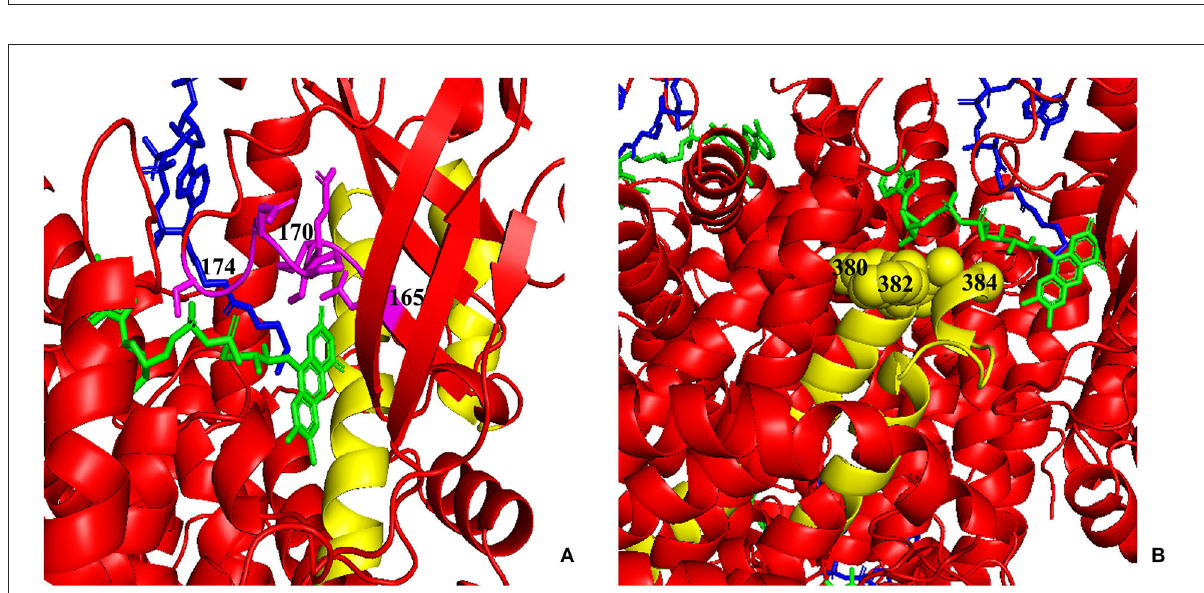
FIGURE7 Three-dimensional (3D) modeling of areas 123–159 and 356–403. (A) Yellow: the 123–159 region; green: FAD; blue: CoA Persulfide; purple: FAD binding sites (numbered). (B) Yellow: the 356–403 region; green: FAD; blue: CoA Persulfide; yellow balls: FAD binding sites (numbered). FAD, flavin adenine